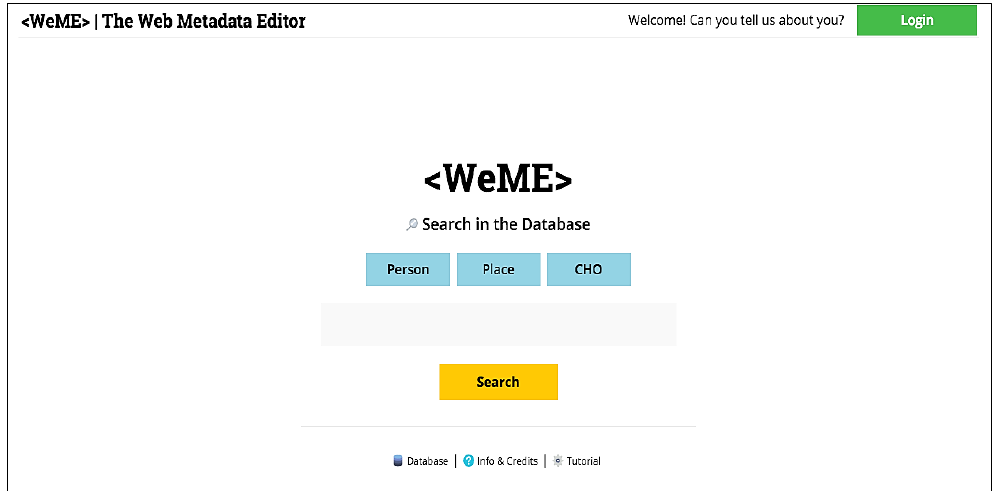
Figure 2. A snapshot of WeME